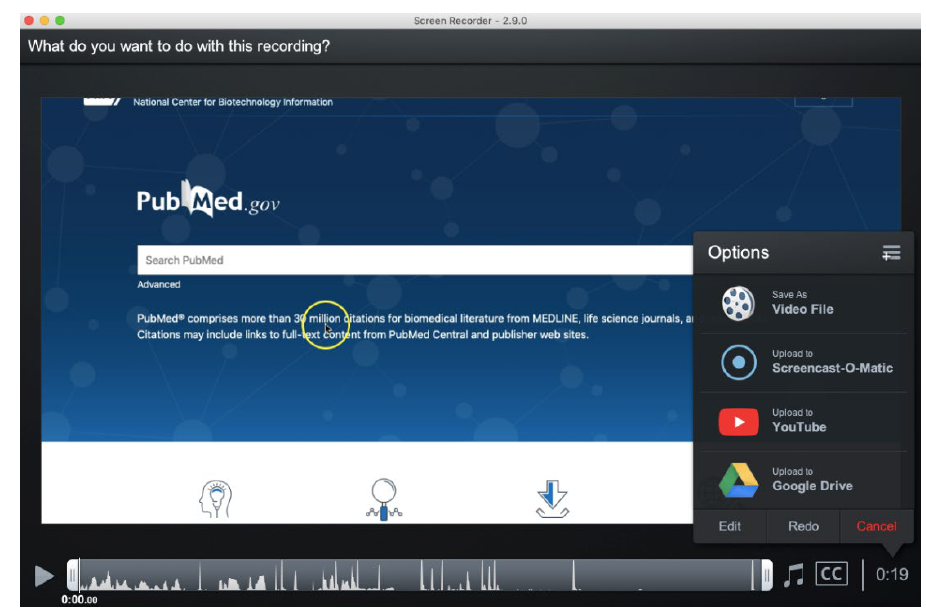
Figure 3 Detailed saving and uploading options